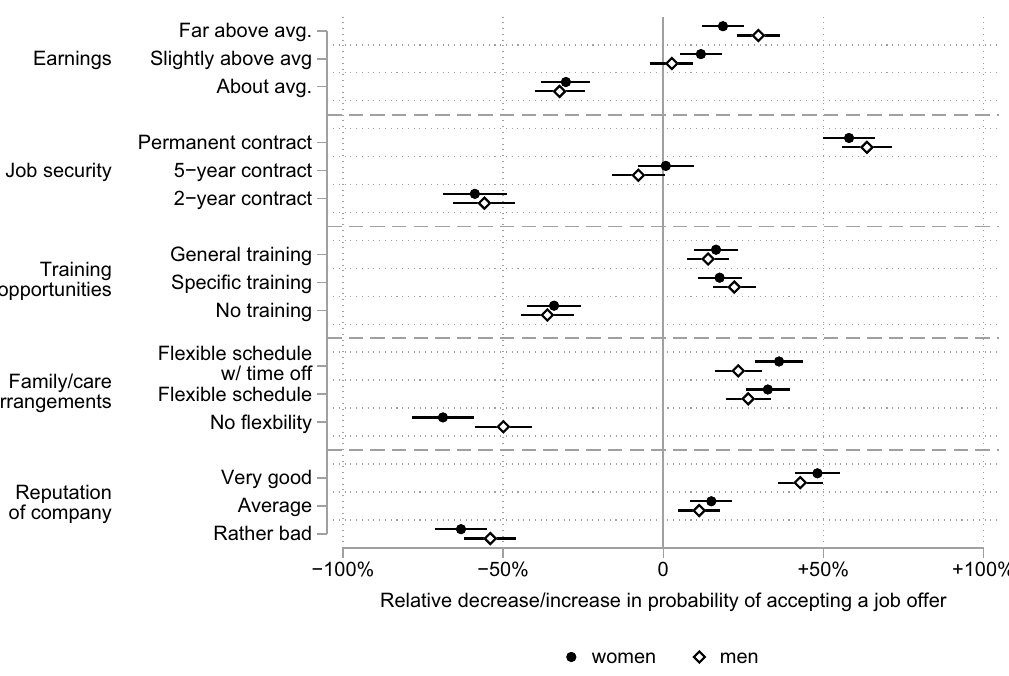
Fig 3. Preferences for job attributes among male and female respondents in the German survey. The figure shows the relative decrease/increase in probabilities (with 95% confidence intervals) of choosing a job due to the respective job attribute.